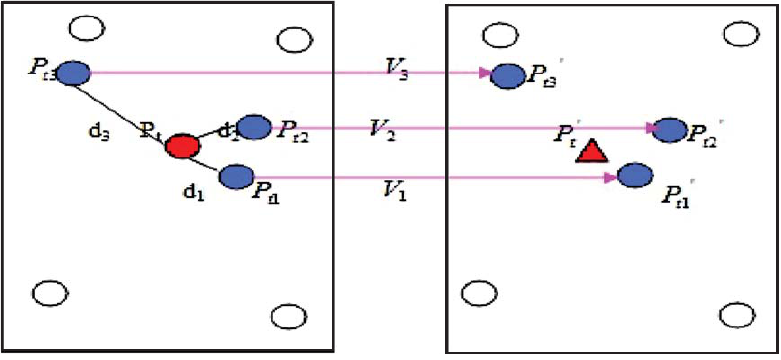
Fig. 3. Missing data recovery